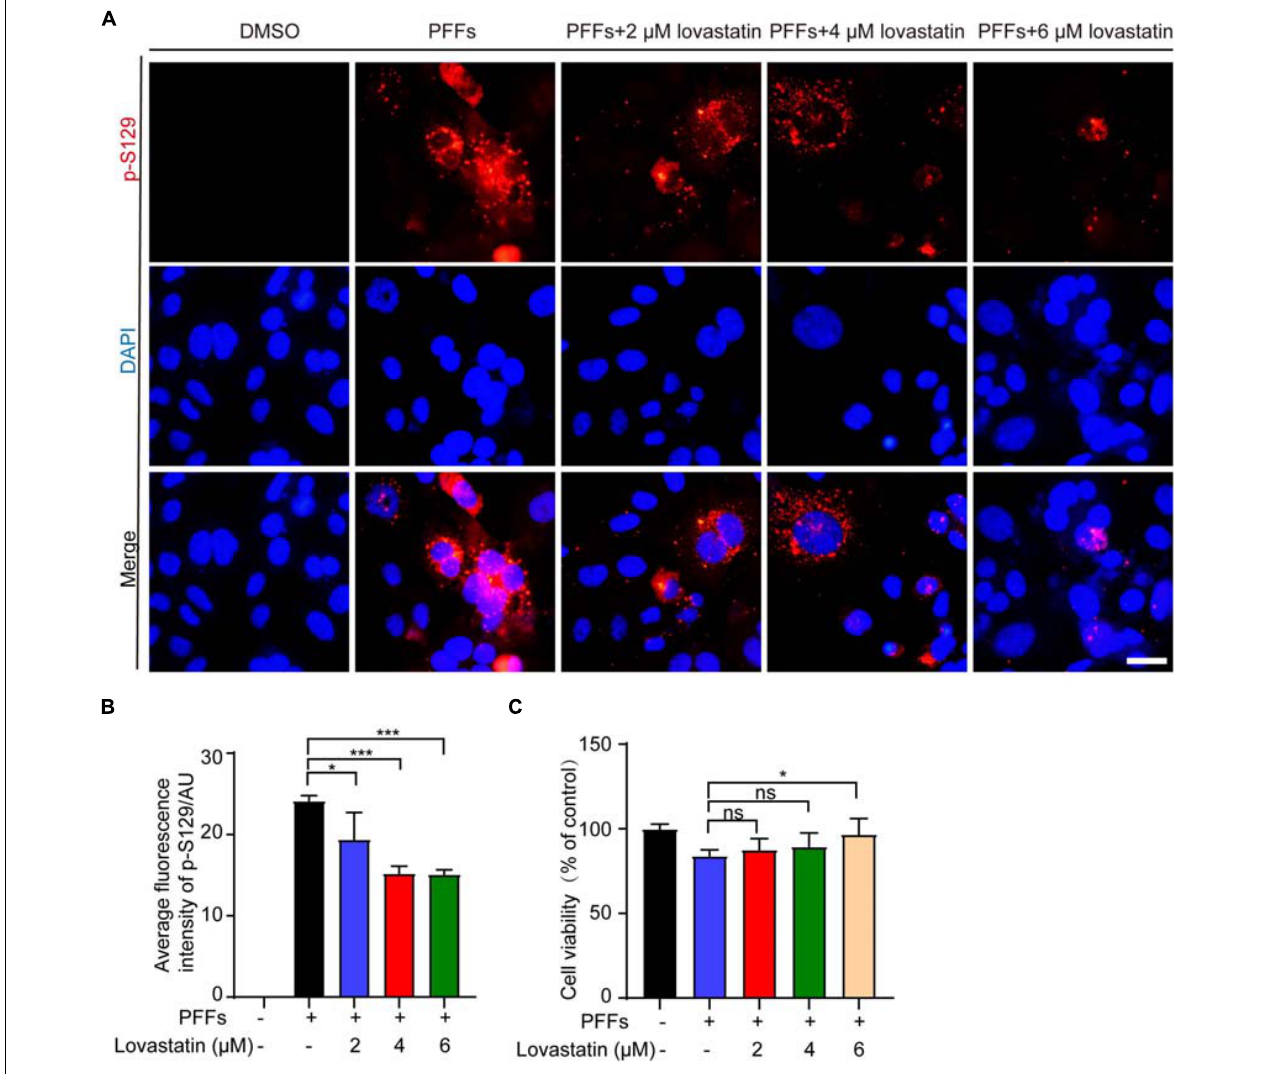
FIGURE 3 | Lovastatin alleviates the phosphorylation of endogenous α -syn in SH-SY5Y cells. (A) Immunostaining for p-S129 α -syn showing that lovastatin reduces the phosphorylation of α -syn in SH-SY5Y cells. Bar = 20 µ m. (B) Quantification of p-S129 α -syn. (C) CCK8 analysis showing that 6 µ M lovastatin improves cell viability. All data are means ± SEM, * P < 0.05, and *** P < 0.001, ns: not statistically significant, one-way ANOVA with Tukey’s multiple comparisons test. All experiments were performed in triplicate for at least three independent